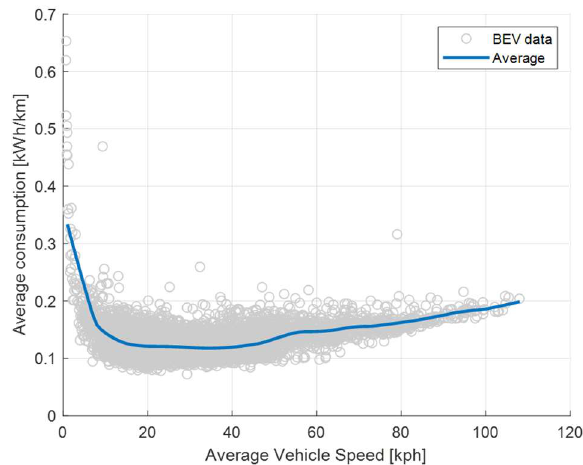
Figure 10. Average battery energy consumption vs average vehicle speed trendline.